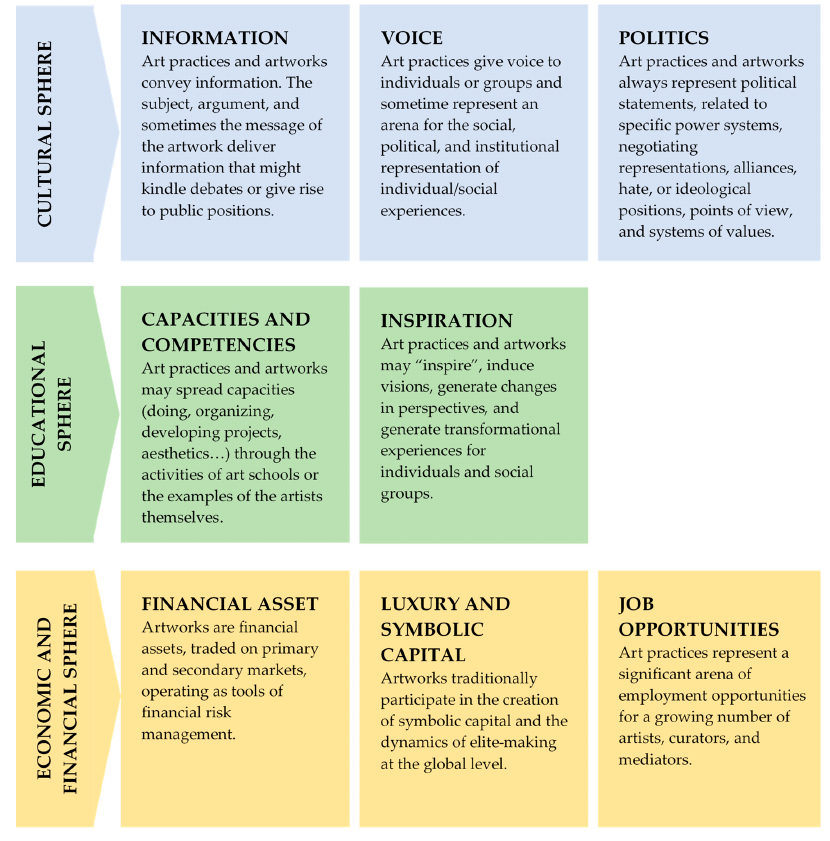
Figure 1. Forms of art system agencies.